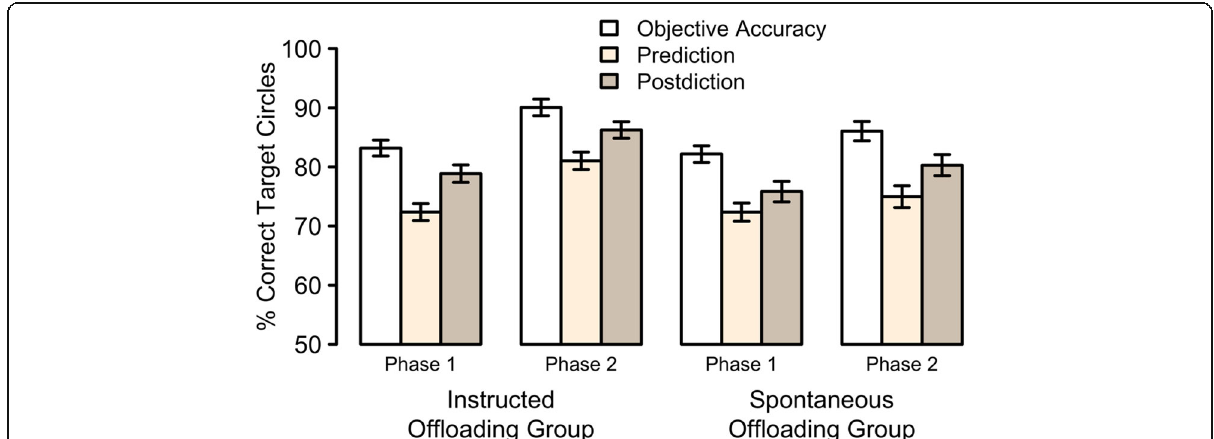
Fig. 3 Percentage of target circles that were moved to the correct border (top/left/right) as a function of group, phase of the experiment, as well type of judgement (objective accuracy, prediction, and postdiction). All error bars are standard errors of the